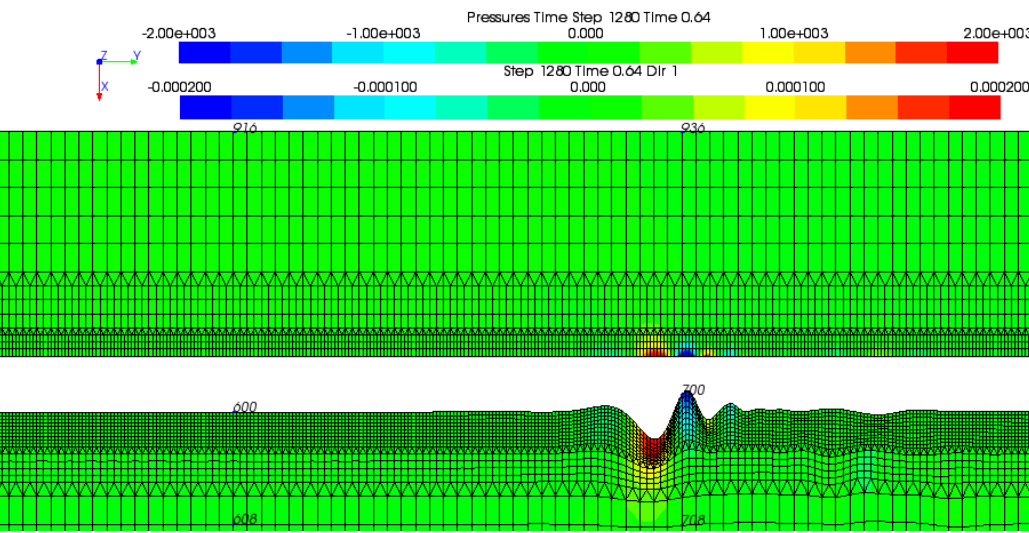
Figure 4. The wavelet is shown 0.64 s after the impact, at 64 m range (nodes 700 & 936). Whilst remaining compact, it has changed from a hump to a dip. The vertical (shown as × axis) sediment displacement shows a dip of >0.2 mm, creating a local peak pressure (>2 kPa) in the water.